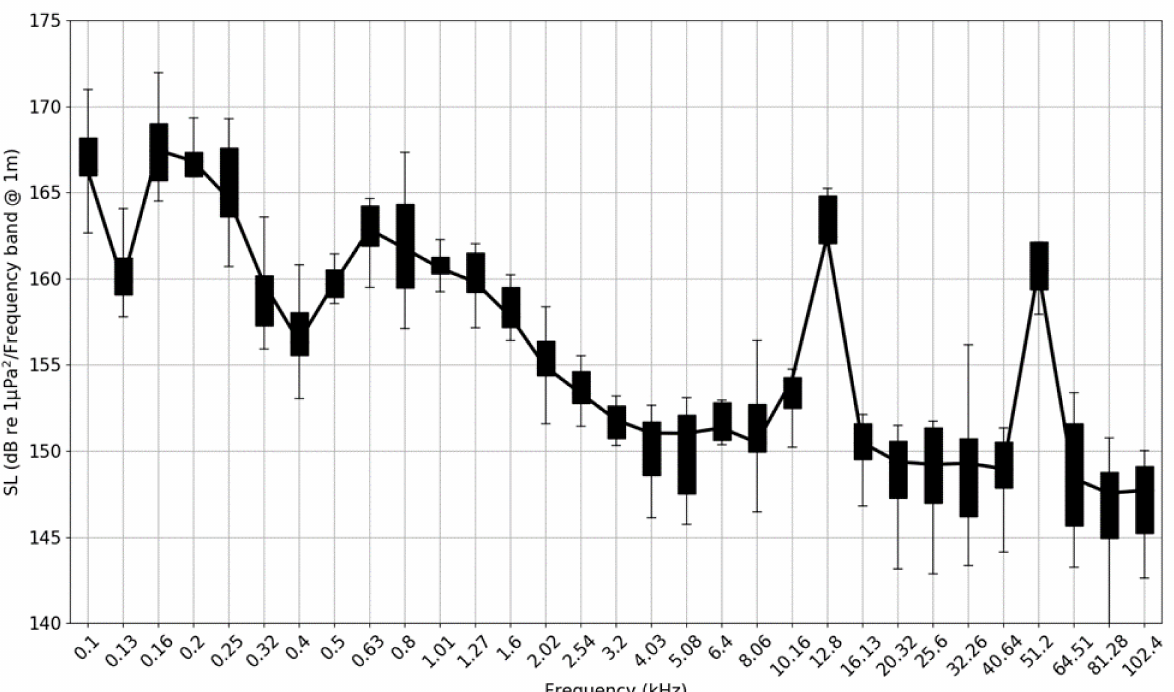
Figure 7. Box plot of third-octave band (center frequency of each band as indicated) calculated SLs for the CCGS Vector at the closest point of approach for 13 transects. In each box the solid horizontal line in the middle is the median (L 50 ) value, and the boxes are defined by L 25 and L 75 . The whiskers extend outside the boxes to the highest and lowest observations that fall within 1.5 times the interquartile range (IQR). The IQR is the range measured from the 25th to the 75th percentile (L 25 to L 75